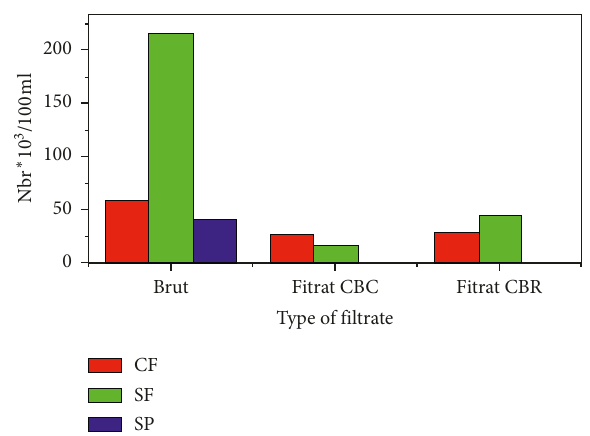
Figure 8: Microbiological characterization of the effluent before and after treatment by the two types of